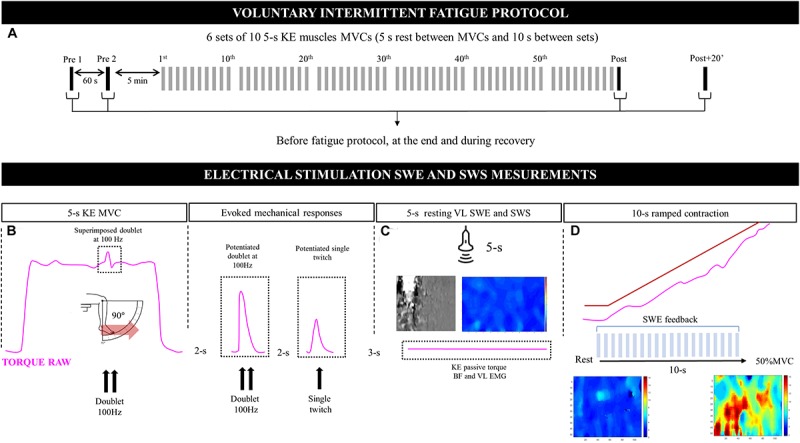
Design of the voluntary intermittent fatigue protocol (top; A), consisting of a series of voluntary force, electrical stimulation, and muscle viscoelasticity measurements performed before and after the fatigue protocol (bottom; B–D). KE, knee extensors; MVC, maximal voluntary contraction; SWE, shear-wave elastography; EMG, surface electromyography; VL, vastus lateralis; BF, biceps femoris; SWS, shear-wave spectroscopy.